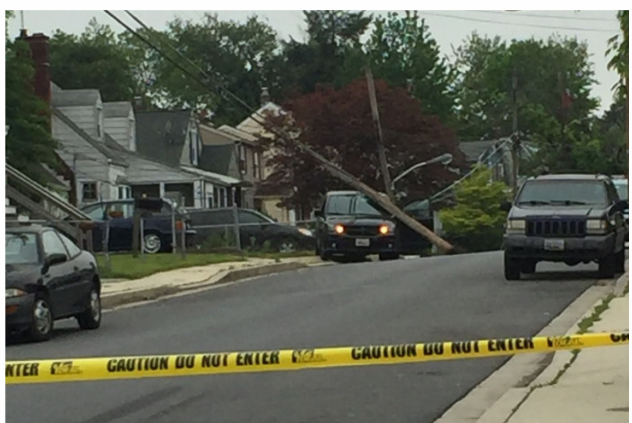
Figure 1. Accident of a wooden utility pole failure in Baltimore in 2019.